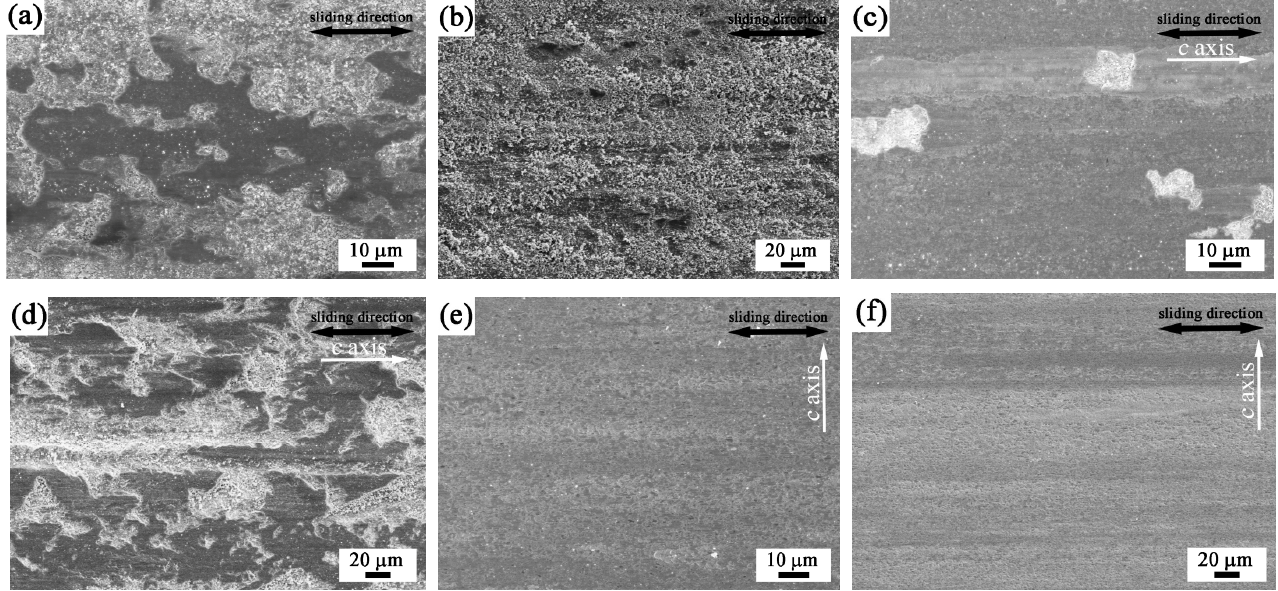
Fig. 3 SEM micrographs of worn surface of tailored Ti 3 AlC 2 ceramic under the loads of 1 and 9 N along the different texture directions: (a, b) TTS sample, (c, d) TSS-1 sample, and (e, f) TSS-2